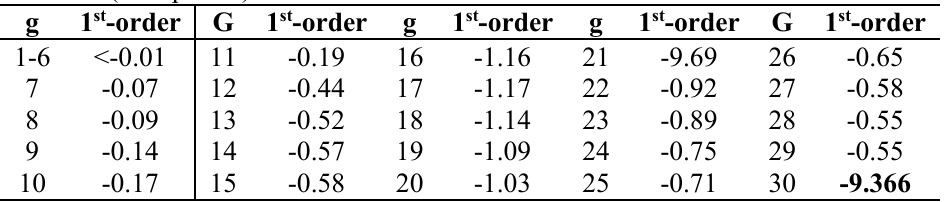
Table 1. First-order relative sensitivities, cross sections of 1 H (isotope i